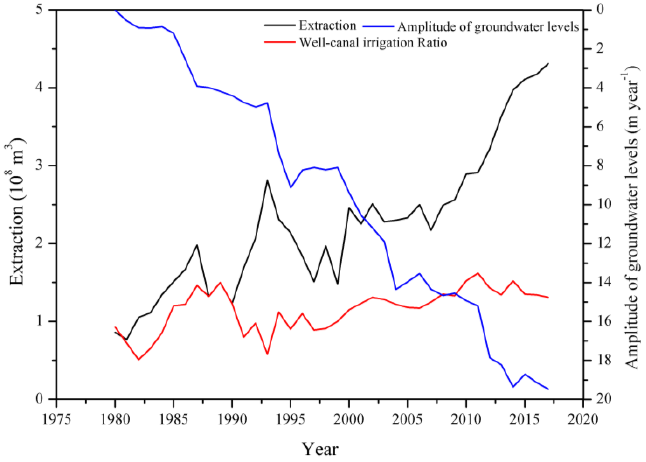
Figure 9. The effect of groundwater extraction and the well – canal irrigation ratio on groundwater